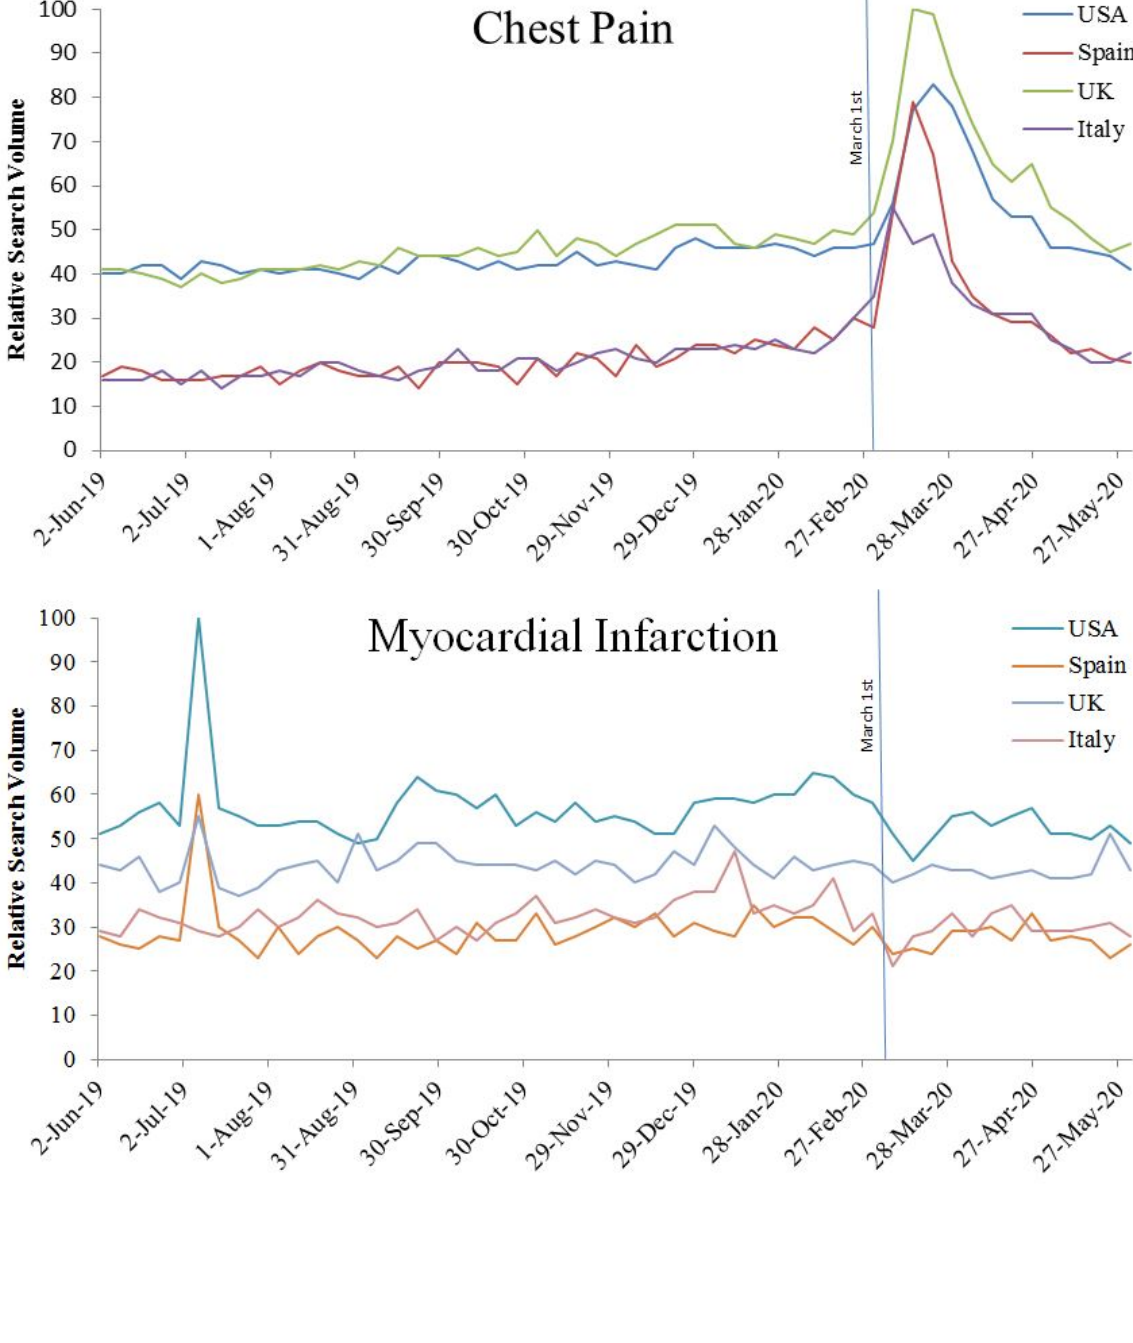
Figure 1. Relative daily search frequency of chest pain (top) and myocardial infarction (bottom) from June 1, 2020, to May 31, 2020, in the United States, United Kingdom, Spain, and